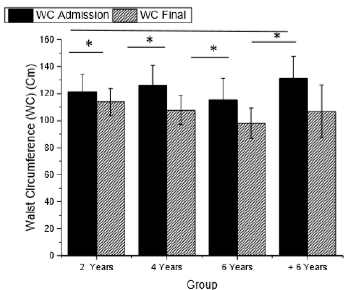
Figure 3. Waist circumference (WC) in the different groups ( p < 0.001, f2 of Cohen = 0.356).